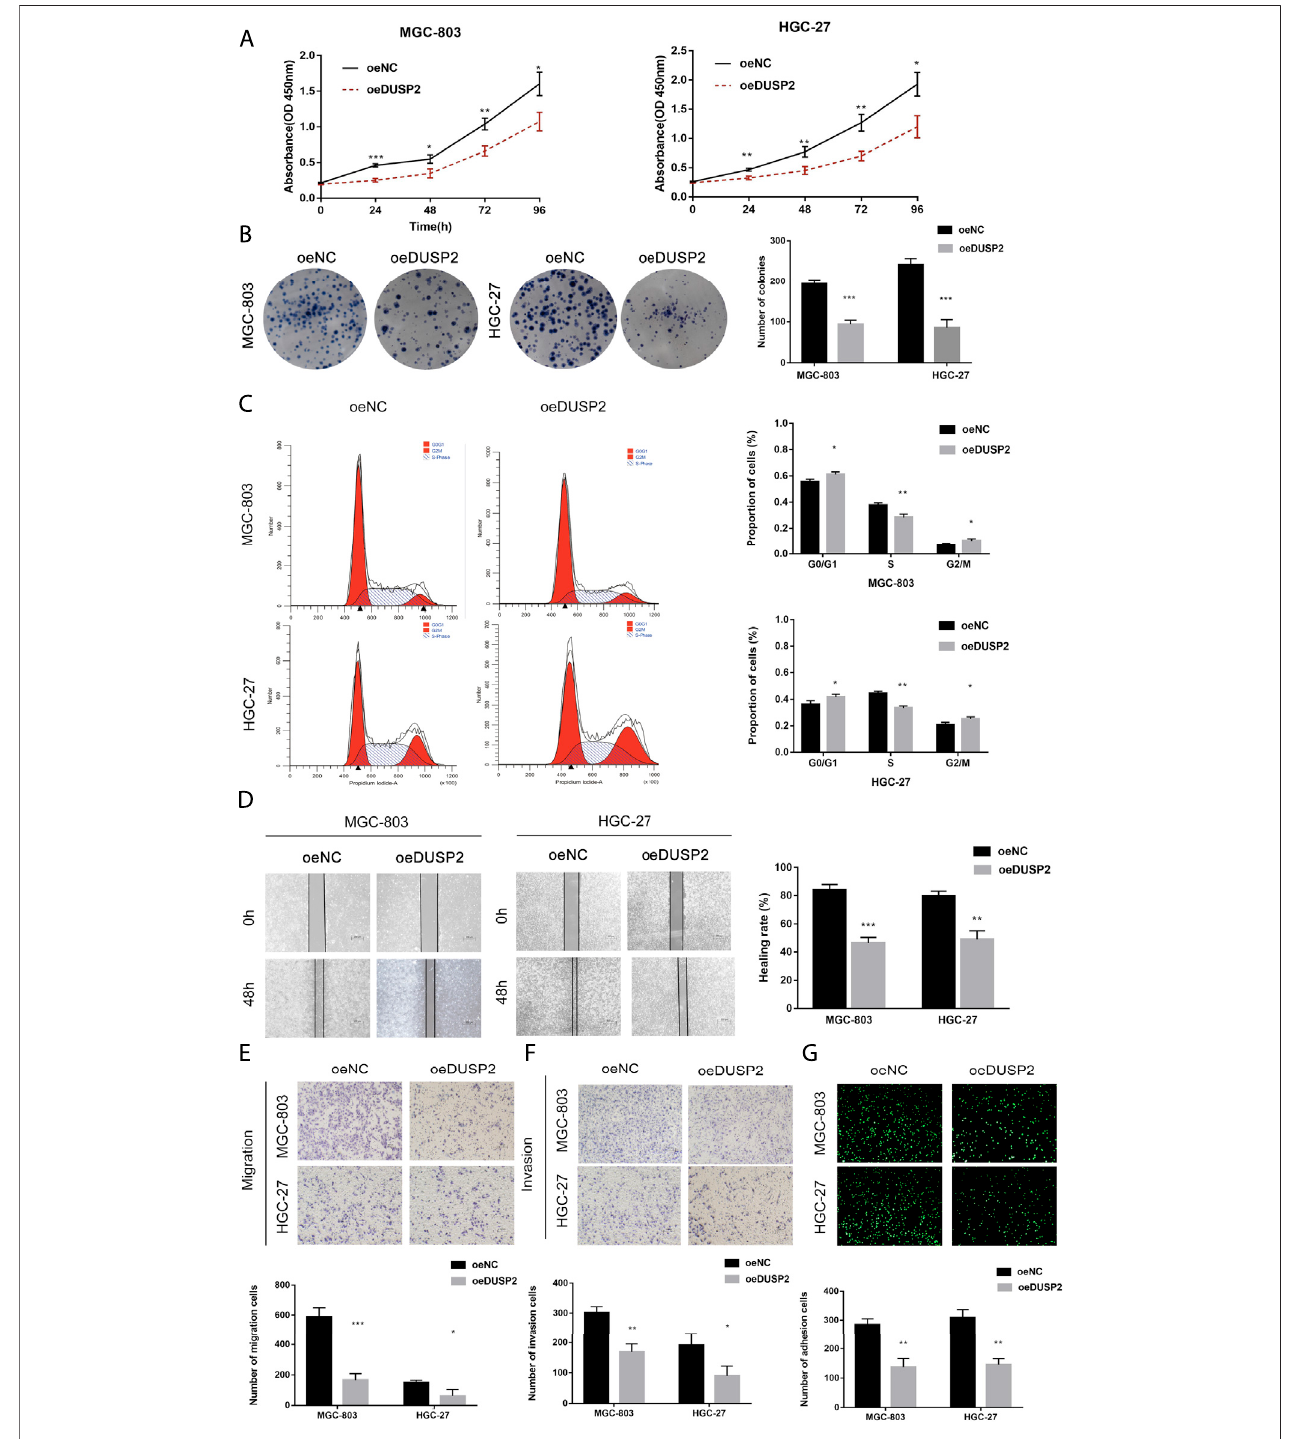
FIGURE 5 | DUSP2 inhibits proliferation, migration, invasion and adhesion in gastric cancer. (A) CCK-8 cell proliferation assay detects cell viability by overexpression for DUSP2 in MGC-803 and HGC-27. (B) Cloning experiment detects cell growth by overexpression for DUSP2 in MGC-803 and HGC-27. (C) Flow cytometry detects cell cycle by overexpression for DUSP2 in MGC-803 and HGC-27. (D) Wound-healing experiments detects cell migration by overexpression for DUSP2inMGC-803andHGC-27. (E) TranswellexperimentdetectscellmigrationbyoverexpressionforSKA3inMGC-803andHGC-27. (F) Transwellexperiment detects cell invasion by overexpression for SKA3 in MGC-803 and HGC-27. (G) Adhesion experiment detects cell adhesion by overexpression for SKA3 in MGC-803 and HGC-27. Data are shown as mean ± SD for triplicate experiments. The two-tailed Student ’ s unpaired t -test was used. * p < 0.05, ** p < 0.01, *** p < 0.001.